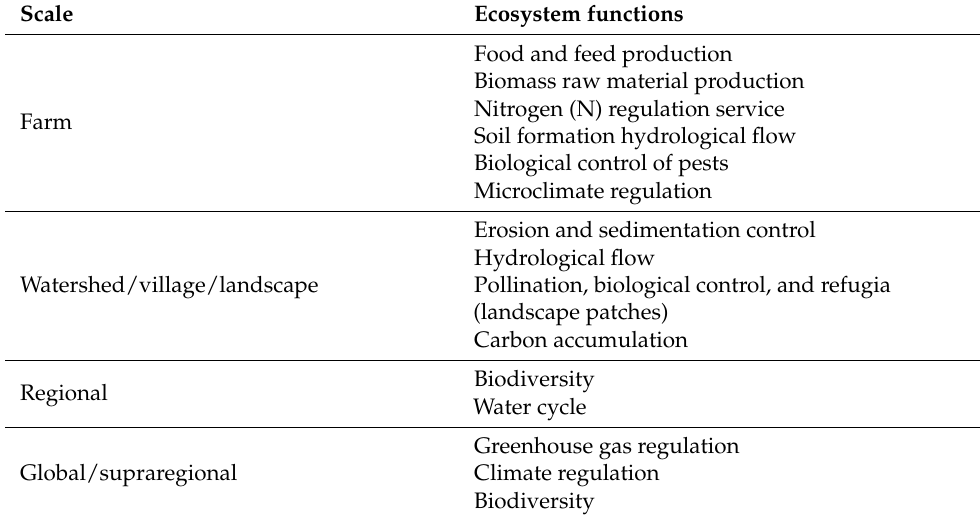
Table 1. Principal ecosystem services of agroforestry trees at different scales (Adapted with permis- sion from Ref. [21]. 2021 CAB